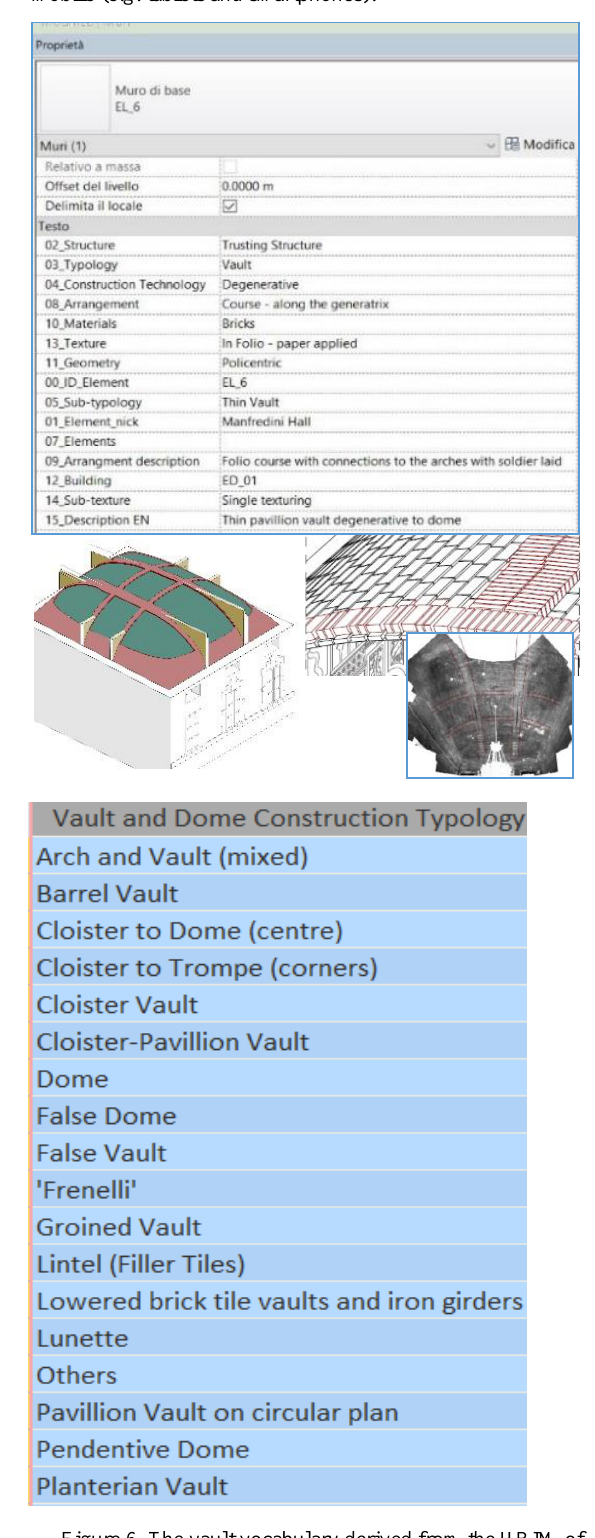
Figure 6. The vault vocabulary derived from the HBIM of palace (the Magio Grasselli Palace in Cremona): the bottom up process will allow to compare different HBIM nodes within the Hub